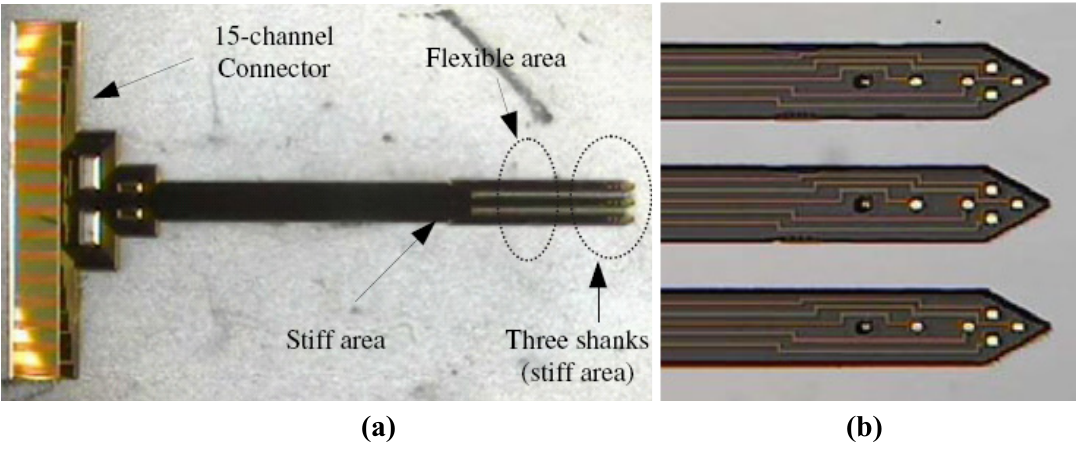
Figure 14. Optical microscope images of the polyimide neural probes (a) View of the electrode. (b) Top view of the three shanks. Reprinted from [112], with permission from Institute of Physics